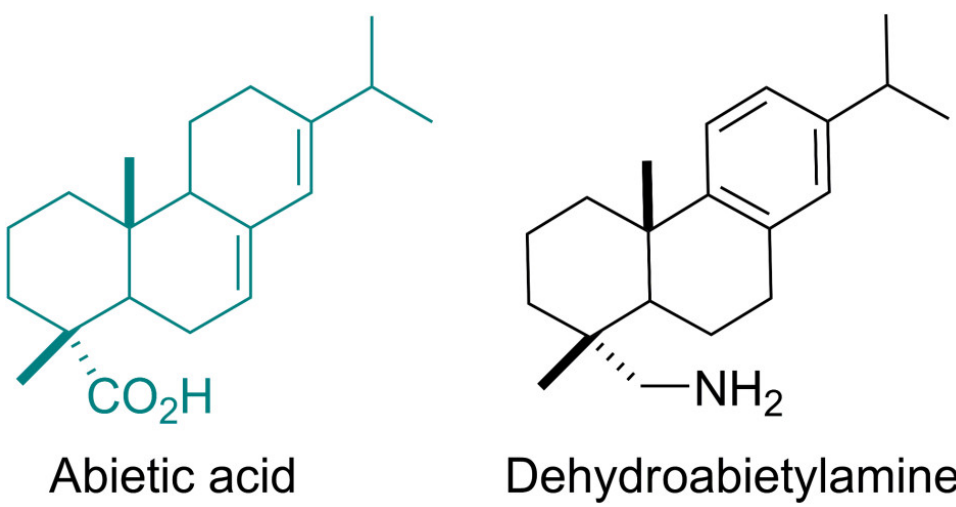
Figure 1. Structure of natural abietic acid and commercially available dehydroabietylamine.